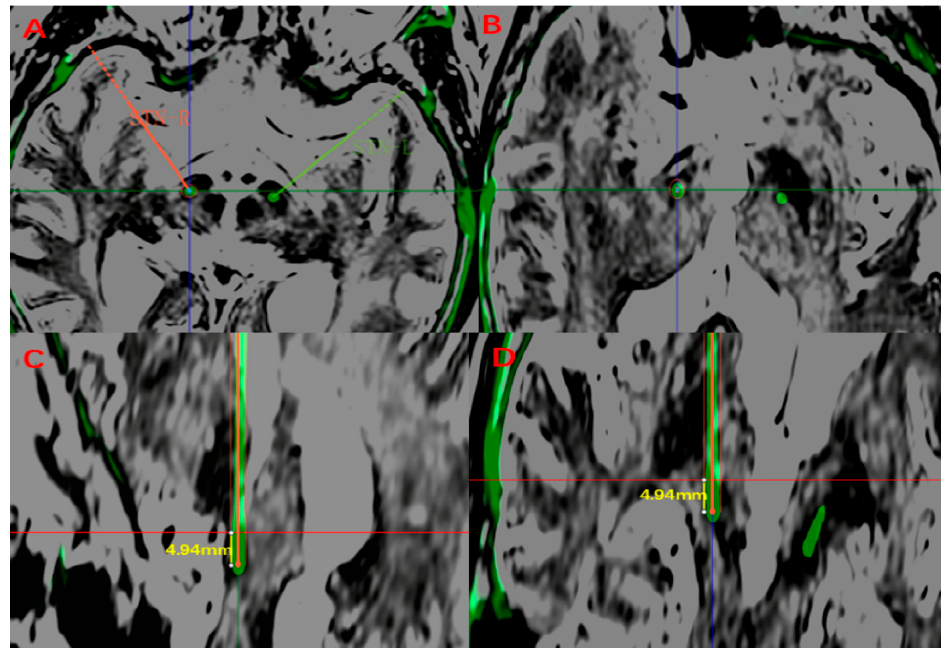
Figure 3. The electrode was reconstructed and measured postoperatively. Reconstructed views along the planned trajectory (Probe’s eye view) of 1 representative patient are shown to demonstrate the measurement of electrode. ( A ). The postoperative target validation of right STN. ( B ). Showing the entry point of STN by Probe’s eye view. ( C , D ). The electrode length was measured from the entry point slice (shown by the red horizontal line) to the end of planned track, (sagittal and coronal view).